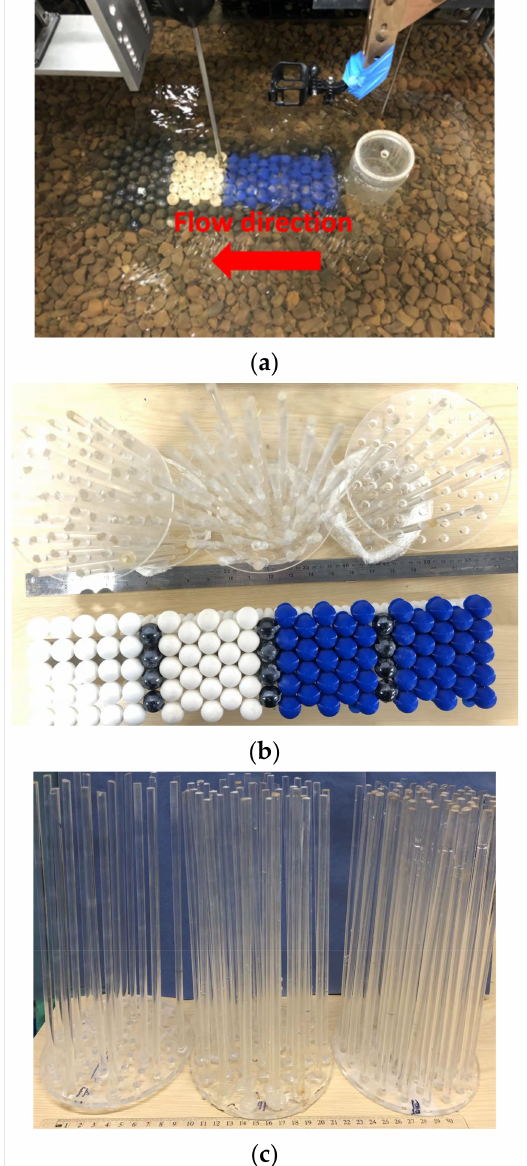
Figure 5. ( a ) Perspective view of the test section involving the 3D printed layer of spherical uniformly sized particles (with diameter 2.5 cm) downstream of the flow obstacle. Particle entrainments are validated with the top view camera (see holder above the water surface) and flow measurements are obtained with the Vectrino I ® ADV (Nortek, 1351 Rud, Norway); ( b ) top view of the 3D printed bed surface along with the different patch densities; and ( c ) side view of the different patch densities